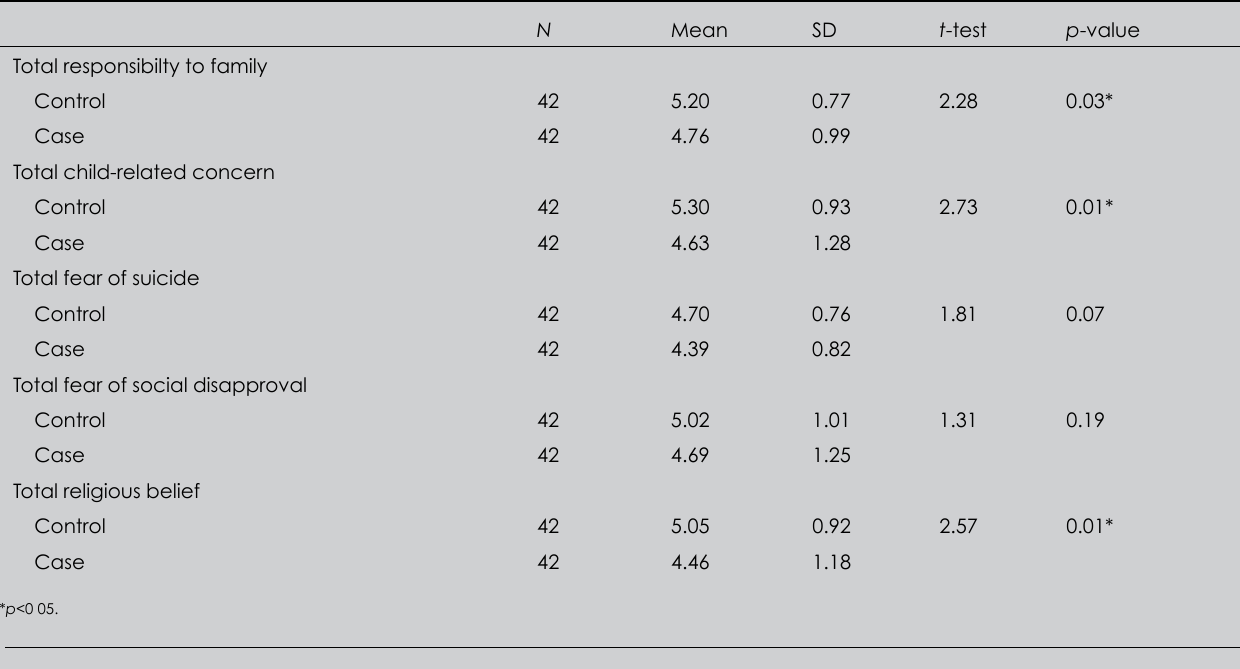
Table IV. Comparison of scores for religious beliefs and responsibility to family between DSH patients and controls